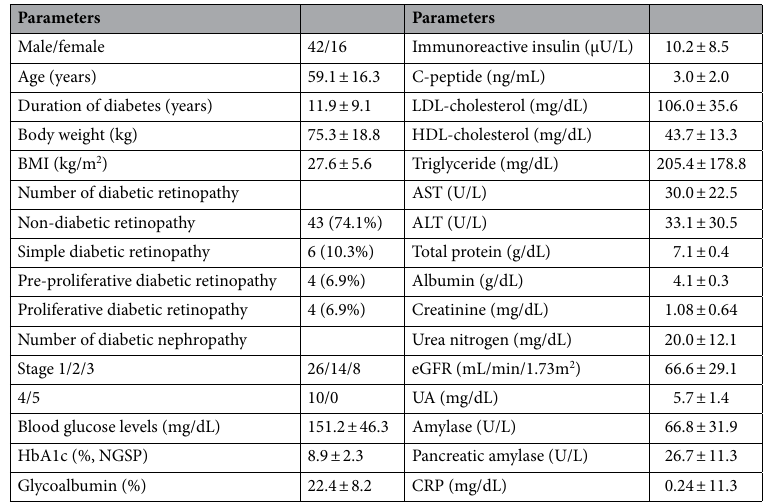
Table 1. Various parameters in subjects with type 2 diabetes mellitus in this study (n = 58). Data presented as mean ± standard deviation. BMI body mass index, LDL cholesterol low-density lipoprotein cholesterol,